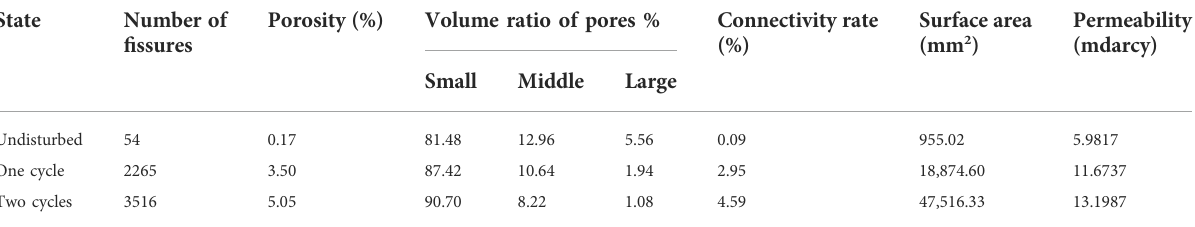
TABLE 4 Statistics of overall characteristics of pores.